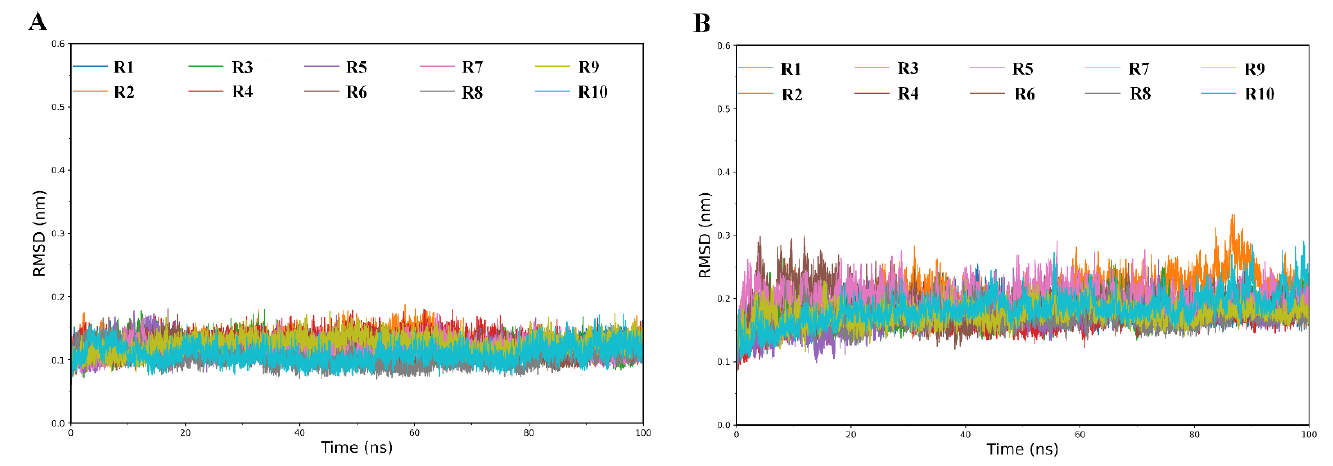
Figure 2. Time-dependent backbone RMSD values of RBD and ACE2 of WT complex relative to the starting structures calculated from the 10 independent replicas (R1–R10). ( A ) RBD; ( B ) ACE2.